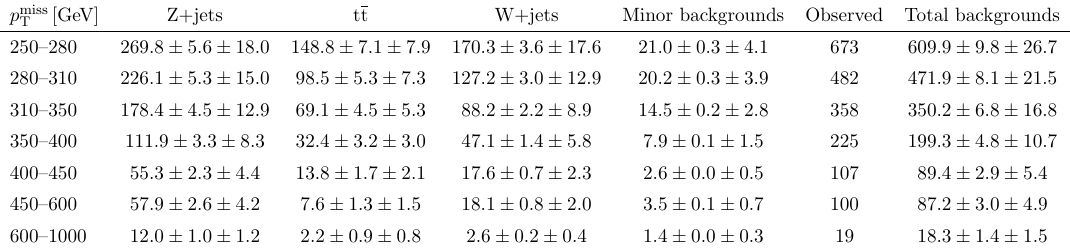
Table 3 . Predicted SM backgrounds and yields in data in each bin of the loose signal region, after performing the (cid:12)t in the control regions only. \Minor backgrounds" refers to the diboson, single t, and QCD multijet backgrounds. The uncertainties are reported as statistical (driven by the data in the CRs), followed by systematic.